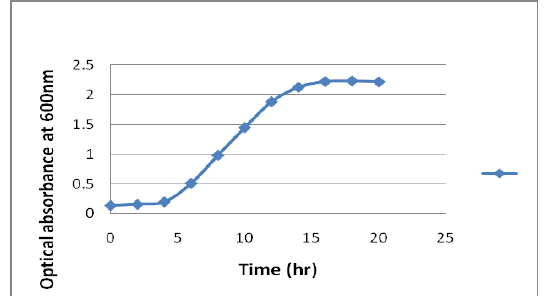
Figure 4. Growth curve for uricase producing